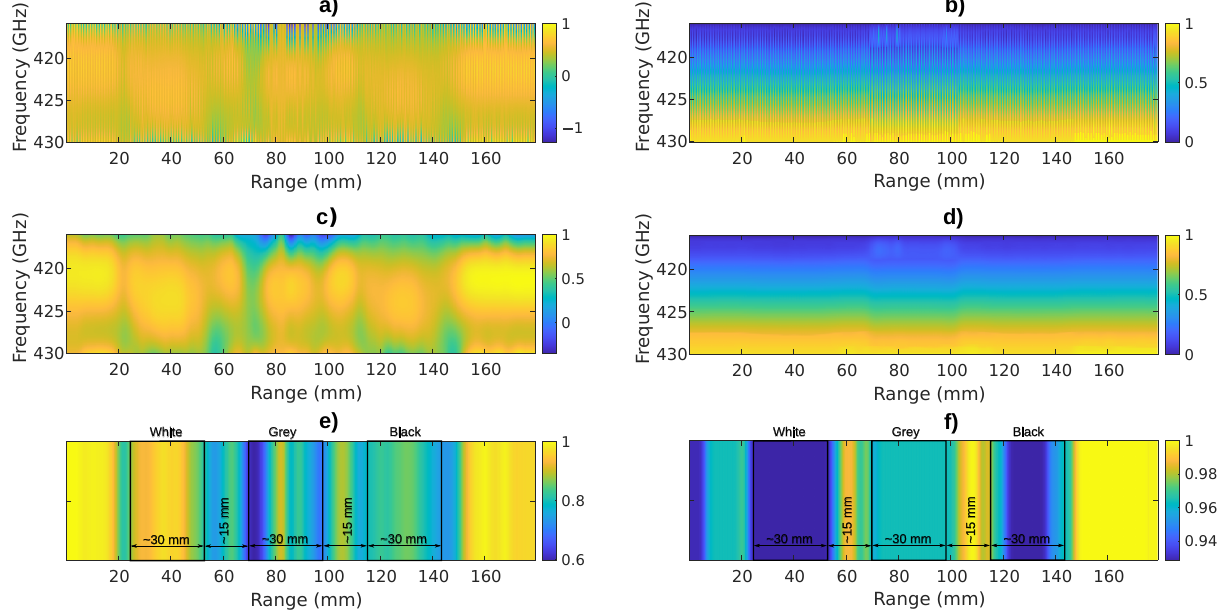
Figure 12. Spectrograms and images for acquisition in the frequency range 416–430 GHz: ( a ) Peak envelope spectrogram. ( b ) Unwrapped phase spectrogram. ( c ) Peak envelope spectrogram processed using GSF. ( d ) Unwrapped phase spectrogram processed using GSF. ( e ) Compressed 1D intensity image with marked plastic plates‘ positions. ( f ) Compressed 1D phase image with marked plastic plates’